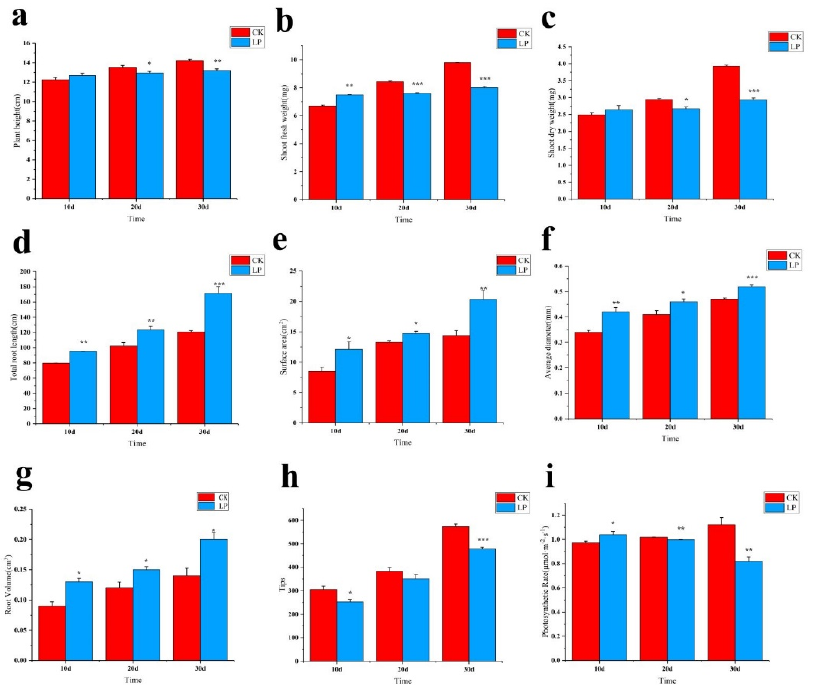
Figure 2. Effects of low − Pi treatment on growth parameters and photosynthetic rate of M. mandshurica. CK: control; LP: low − phosphorus treatment. ( a ) Plant height, ( b ) Shoot fresh weight, ( c ) Shoot dry weight, ( d ) Total root length, ( e ) Surface area, ( f ) Average diameter, ( g ) Root volume. ( h ) Tips. ( i ) Photosynthetic rate. The data were averaged from 15 seedlings, and an average (±standard error) was given for each parameter. According to the Tukey’s test, *** p < 0.01; ** p < 0.01 − 0.05; * p < 0.1 − 0.05. The x − axis represents the processing time, and the y − axis represents the content of the measurement index. (All of the following are the